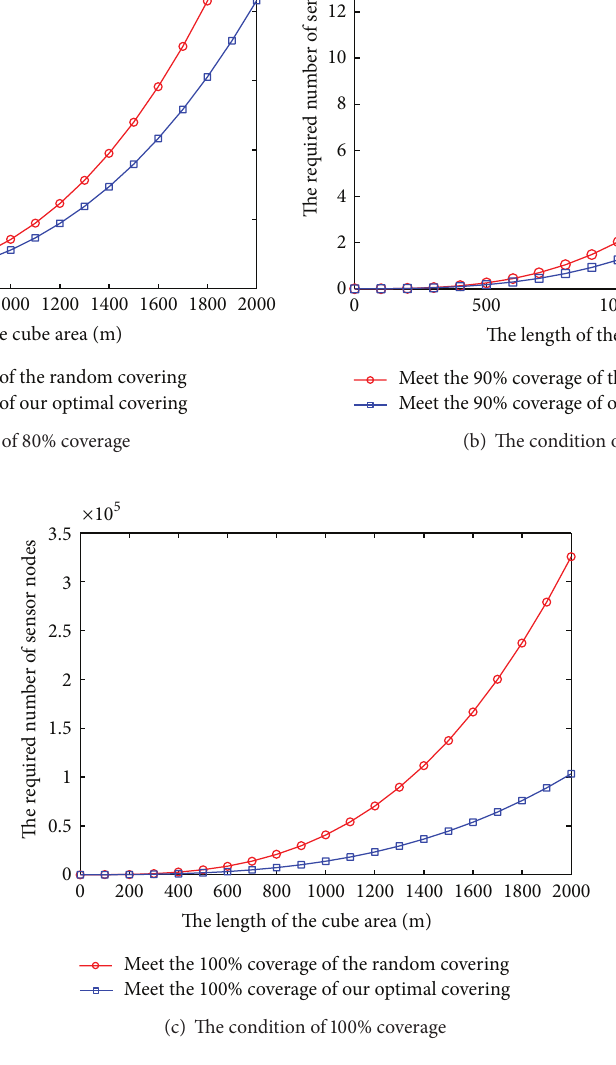
Figure 7: The condition of different coverage using our method and traditional random